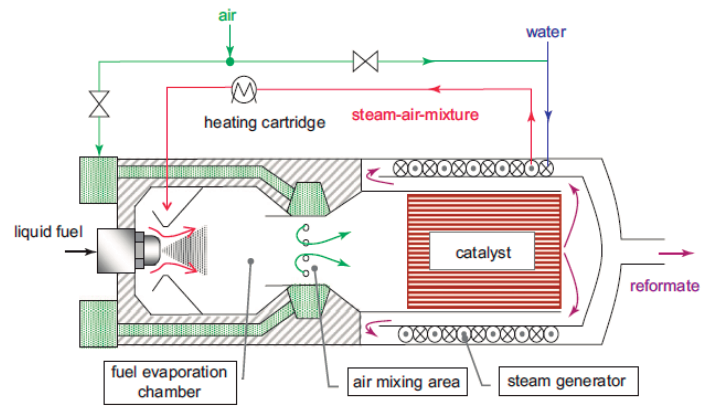
Figure 18. Schematic of ATR 8